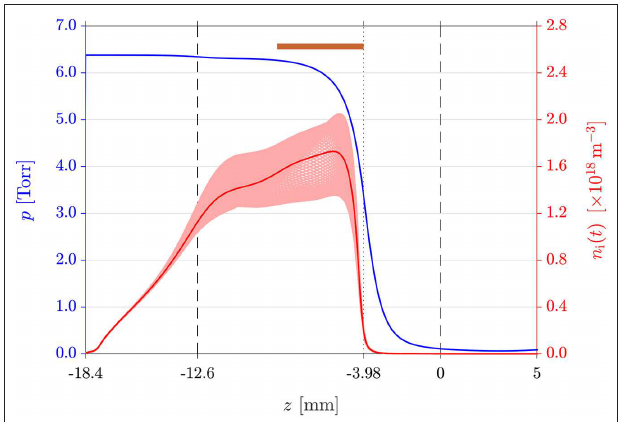
FIGURE 2 | Static pressure p (blue solid line) and temporally varying ion density n i ( t ) (light red lines) and cycle average n i (red solid line) along the z -axis for the 0.1Torr outlet pressure DL simulation. The brown bar at the top shows the axial location of the RF electrode around the nozzle. The entrance and exit of the nozzle are shown by the vertical dashed lines; the nozzle throat (i.e., end of the RF electrode) is indicated by the vertical dotted